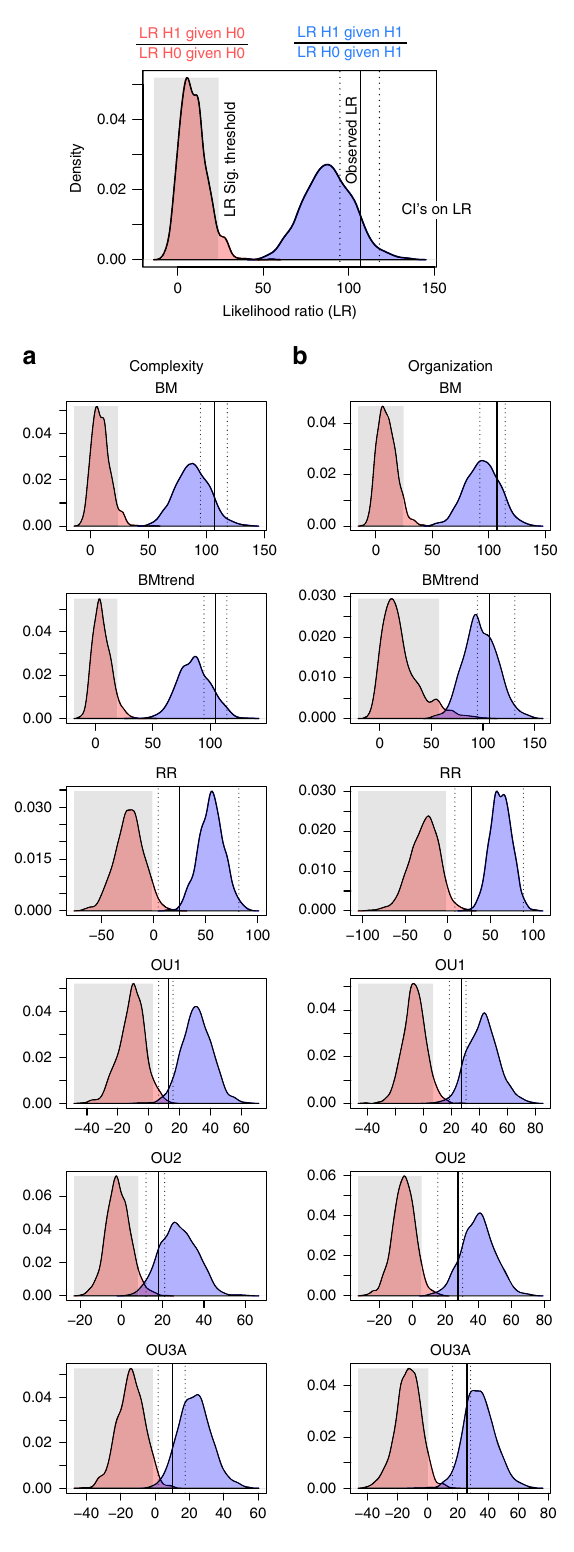
mammals will provide an interesting line of future inquiry.